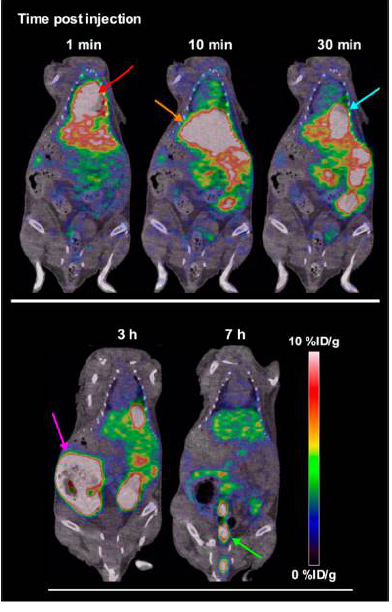
Figure 3. Example of acquired PET/computerized tomography (CT) images of a 45 Ti-compound in mice. Images published by Severin et al. [38].